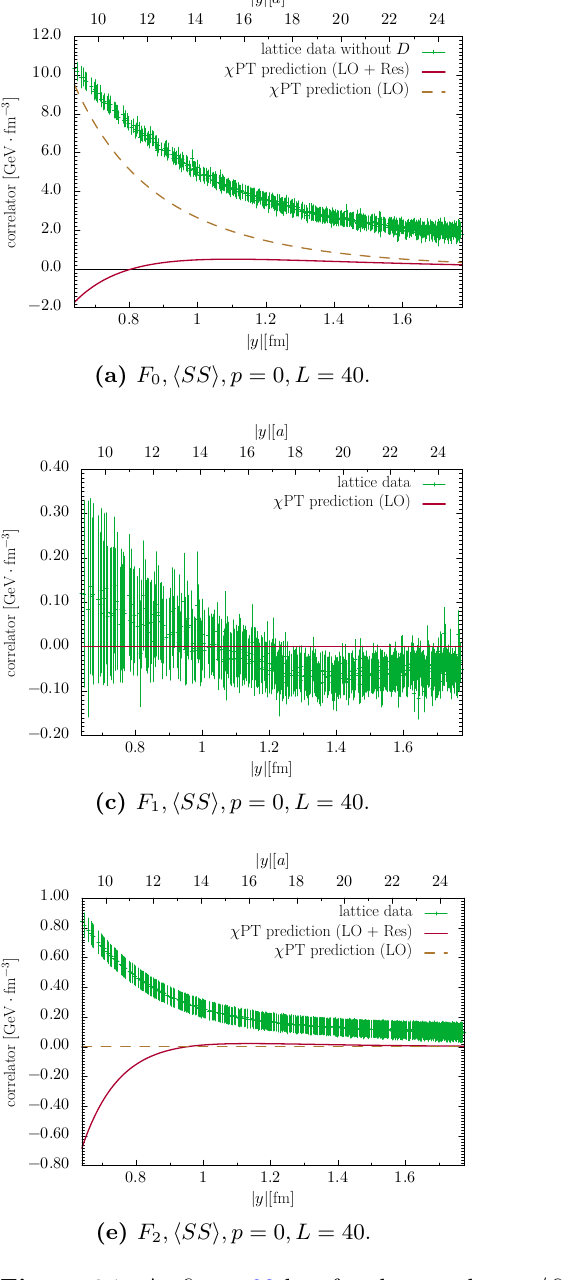
SS and PP in F 1 . h i h i